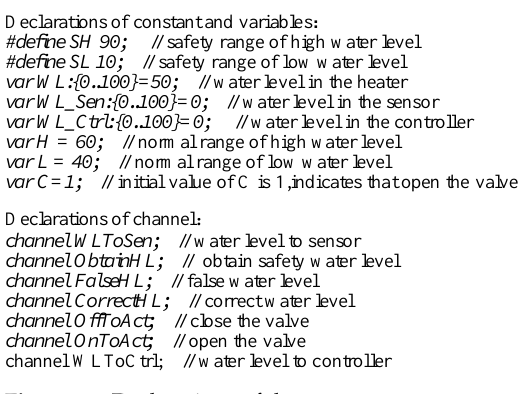
Figure 10. Declarations of the system.